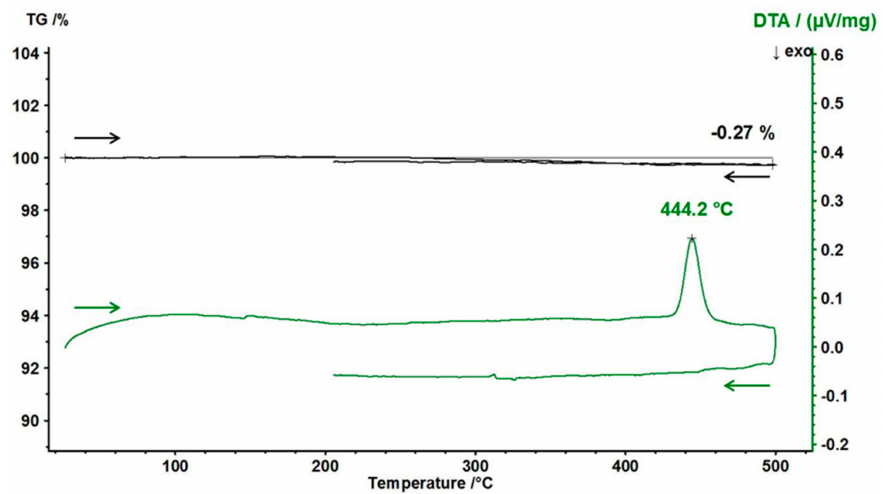
Figure 7. TG (black) and DTA (green) curves of γ -PbTeO 3 as starting